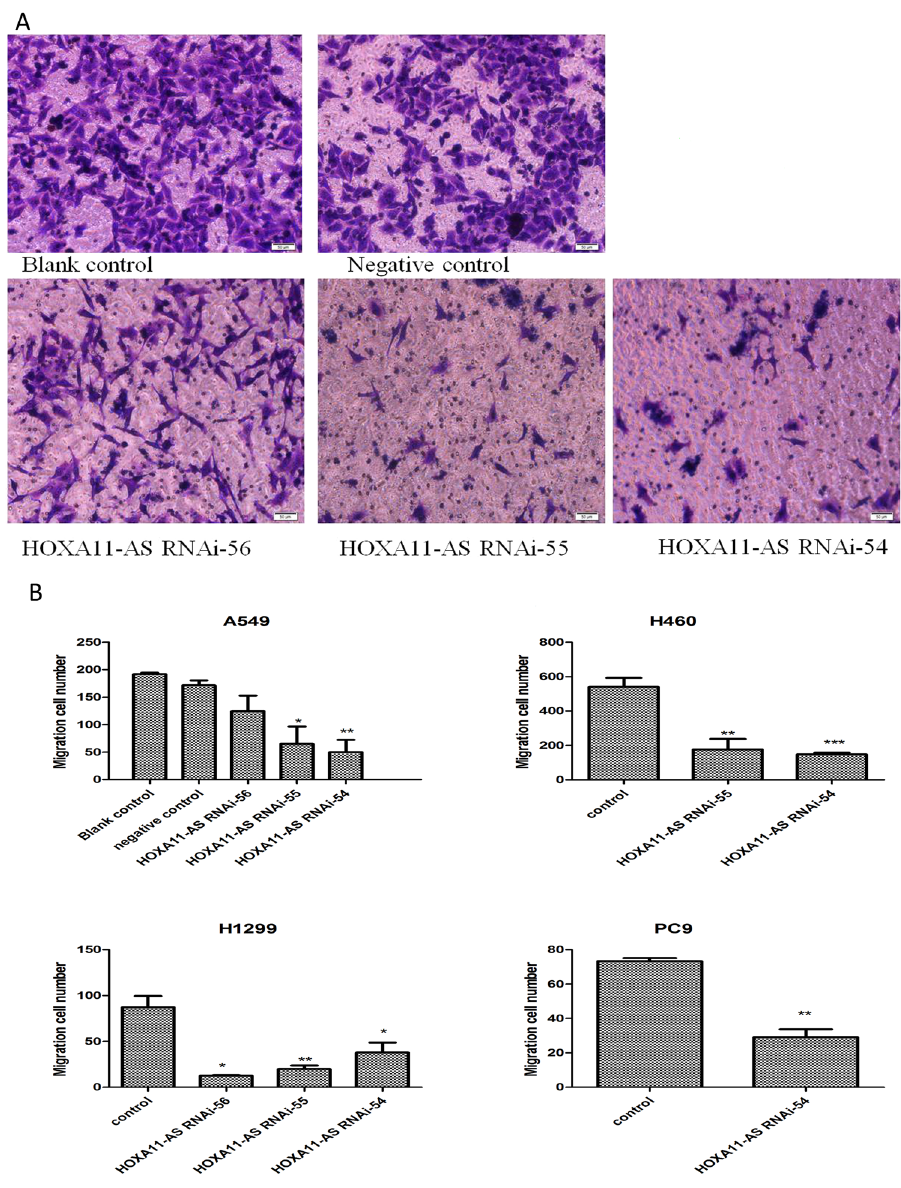
Figure 6. HOXA11-AS RNAi inhibited the migration of A549, H460, H1299 and PC9 cell lines, based on a Transwell migration assay. ( A ) Transwell migration assays were performed to detect the migration ability of A549 cells after transfection with HOXA11-AS RNAi. A549 cells were transfected with the blank control, lenti-control virus and three different interference sequences of HOXA11-AS RNAi (HOXA11-AS RNAi-54, HOXA11-AS RNAi-55 and HOXA11-AS RNAi-56). After 24 hours, cells were stained with crystal violet, and the migratory cells were observed with a microscope (200 × ). ( B ) The numbers of migratory cell in different cell